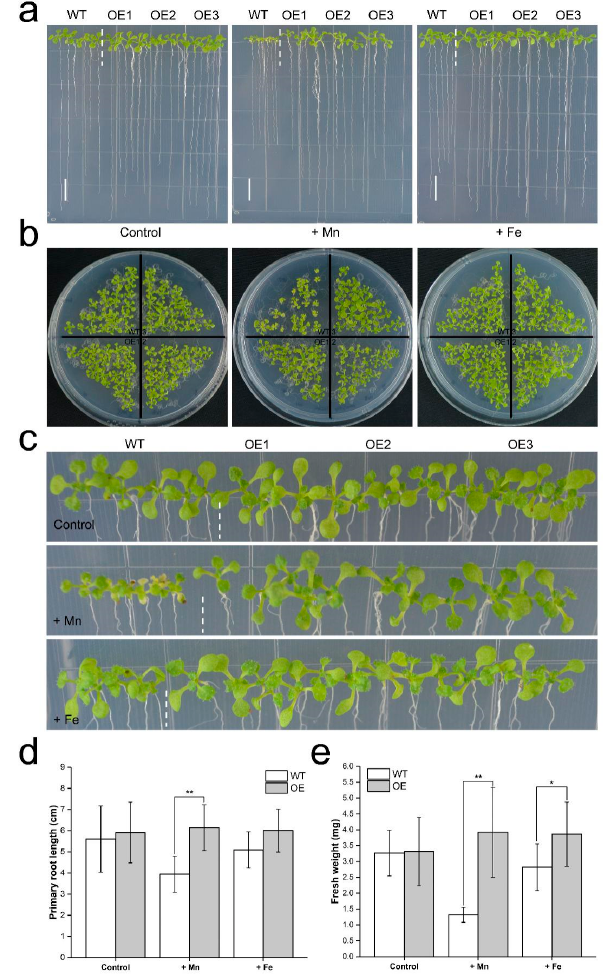
Figure 5. Effects of MnSO 4 and FeSO 4 stress on growth of Arabidopsis over-expressing TuMTP8 compared to WT plants. ( a ) WT and transgenic Arabidopsis seeds were grown on vertical ½ MS solid medium supplemented without (Control) or with 1 mM MnSO 4 and 100 μ M FeSO 4 , respectively. Seedlings were grown in an incubator under a 16 h/8 h photoperiod at 22 °C (day)/20 °C (night) for 14 days. Bars = 1 cm. ( b ) WT and transgenic seeds were grown on ½ MS solid medium supplemented without (Control) or with 1 mM MnSO 4 and 100 μ M FeSO 4 , respectively. Seedlings were grown for 30 days. ( c ) Enlarged images of the shoots in ( a ). ( d , e ) Root length ( d ) and fresh weight ( e ) of WT and TuMTP8 -OE plants described in ( a ). Three biological repeats were performed with similar results. Four to six plantlets per genotype from one plate were measured for each repeat. Data are presented as means ± SE, n ≥ 5. Bars with asterisk (*) are different at p < 0.05, and with (**) are significantly different at p <